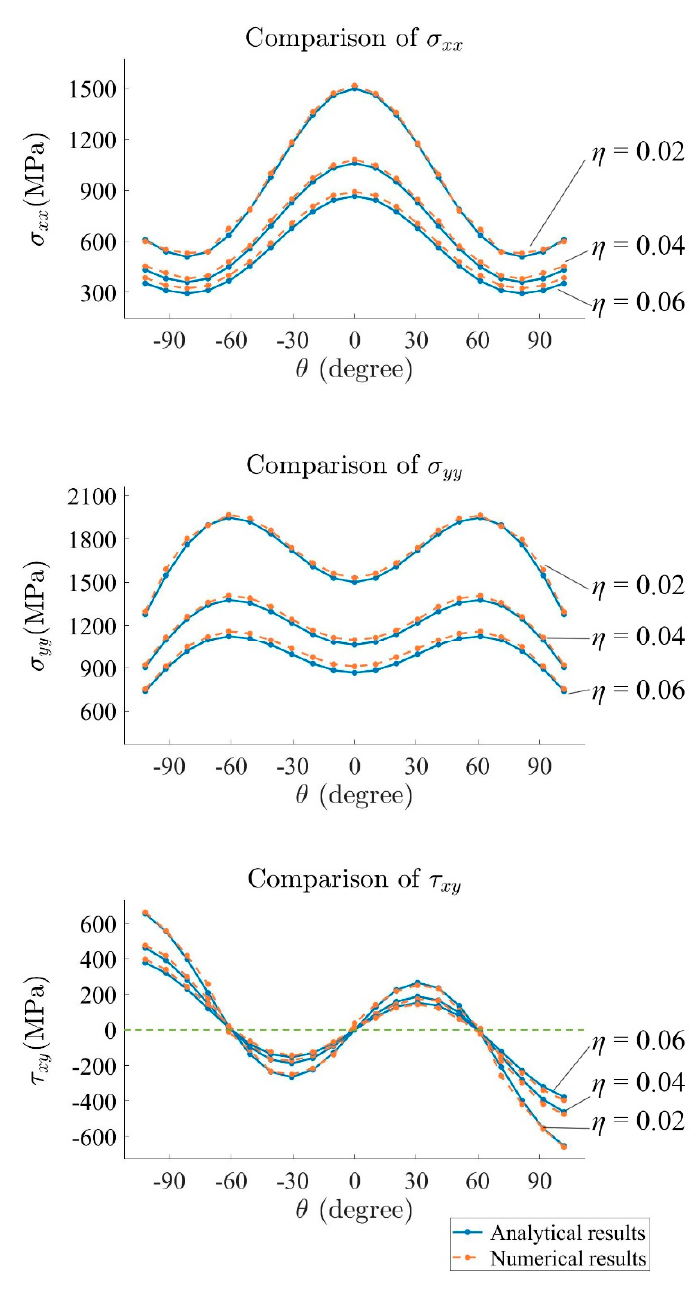
Figure 13. Comparison of stress from numerical and analytical results.